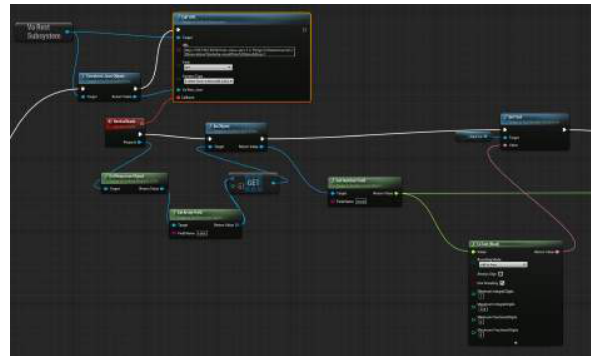
Figure 3. SensorThings access via Unreal Engine